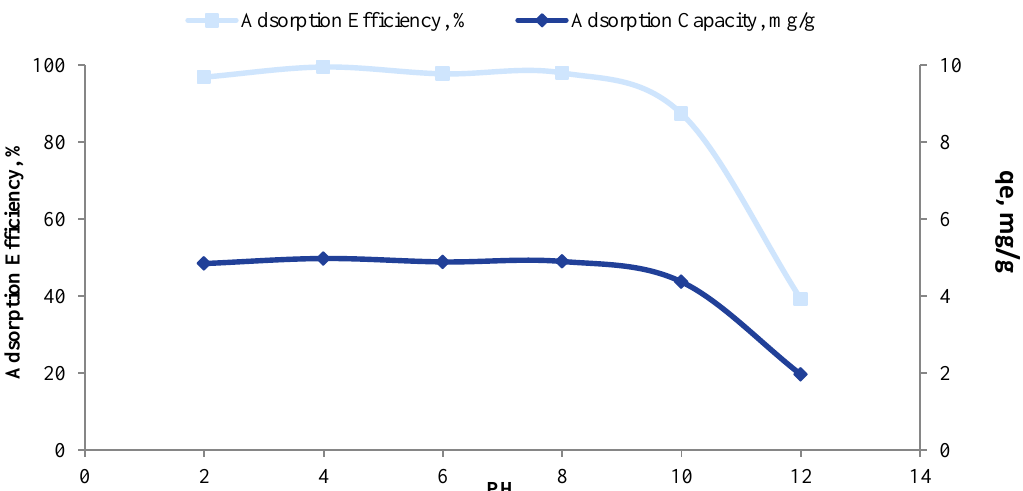
Figure 6. Comparison of the effect of pH changes on removal efficiency of copper using MCh/Fe-Zr nanoparticles (Cr6+ = 5 ppm, speed = 300 rpm, time = 30